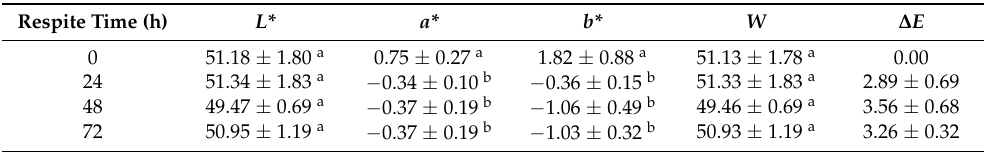
Table 2. The effect of respite time before live transportation on muscle color of blunt snout bream (n = 6 for each respite time).